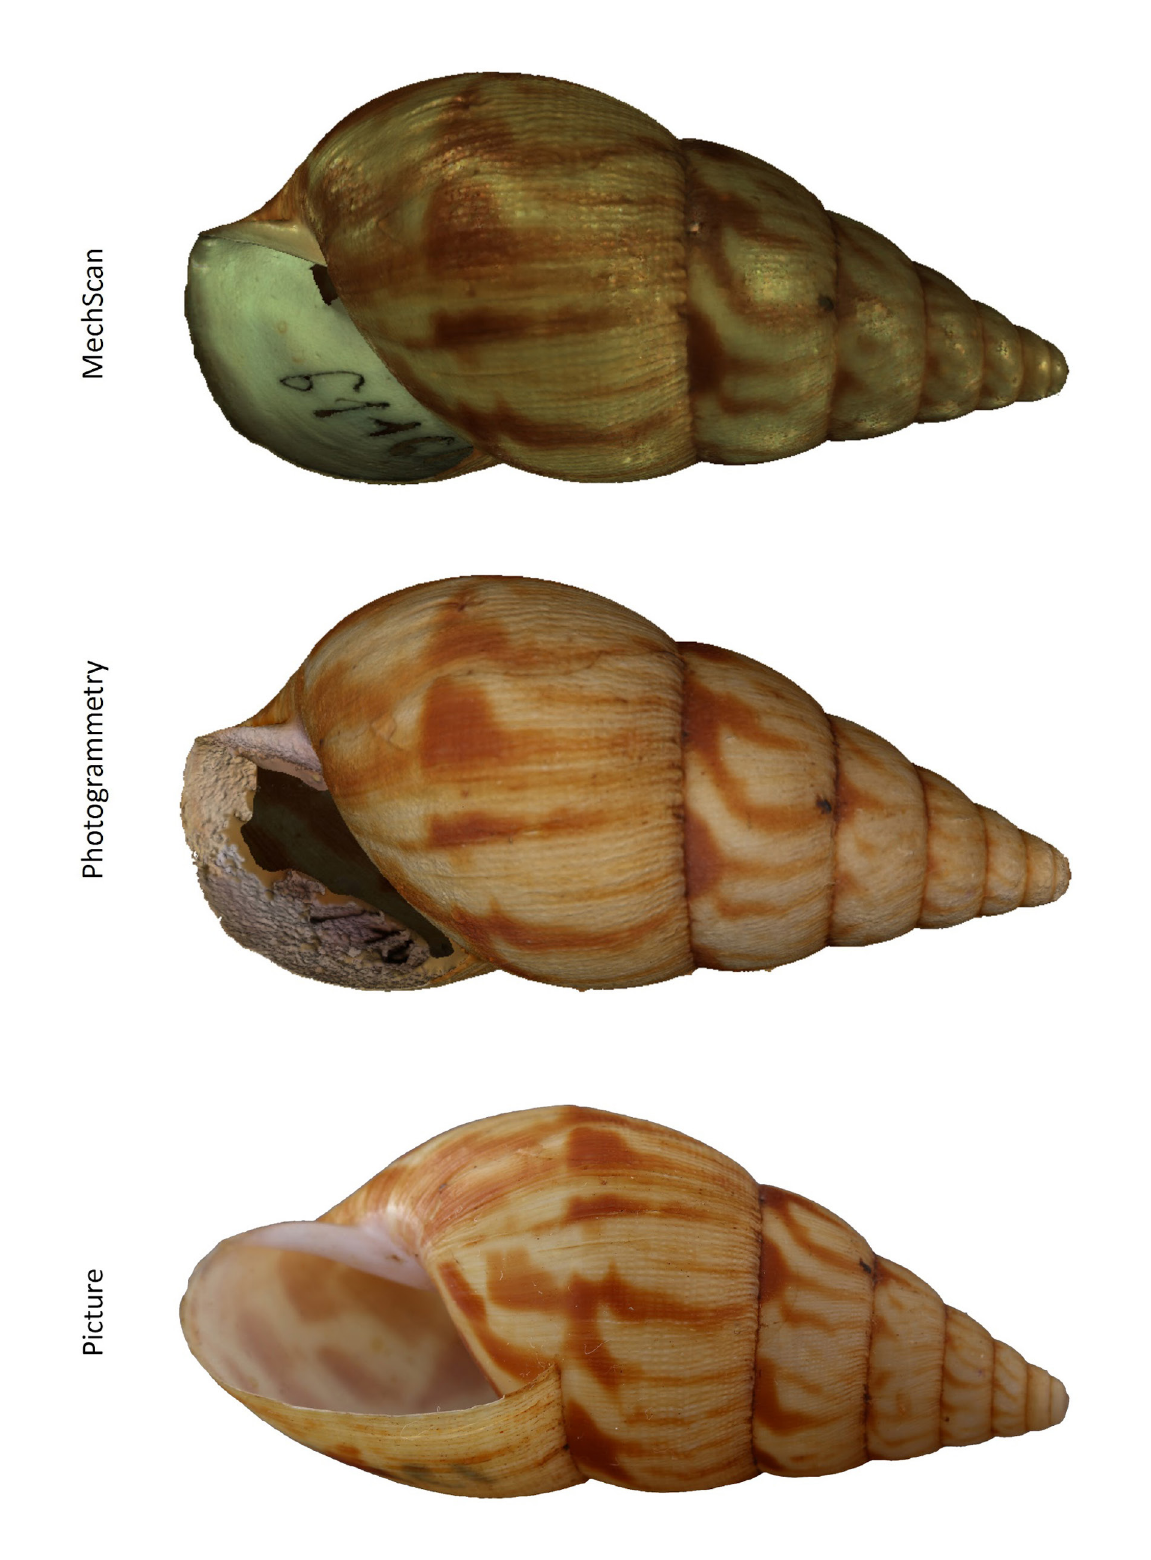
Fig. 6.2. Texture comparison between photogrammetry and MechScan (above) and an actual picture captured by a Canon 700D with 100 mm macro lens of the shell